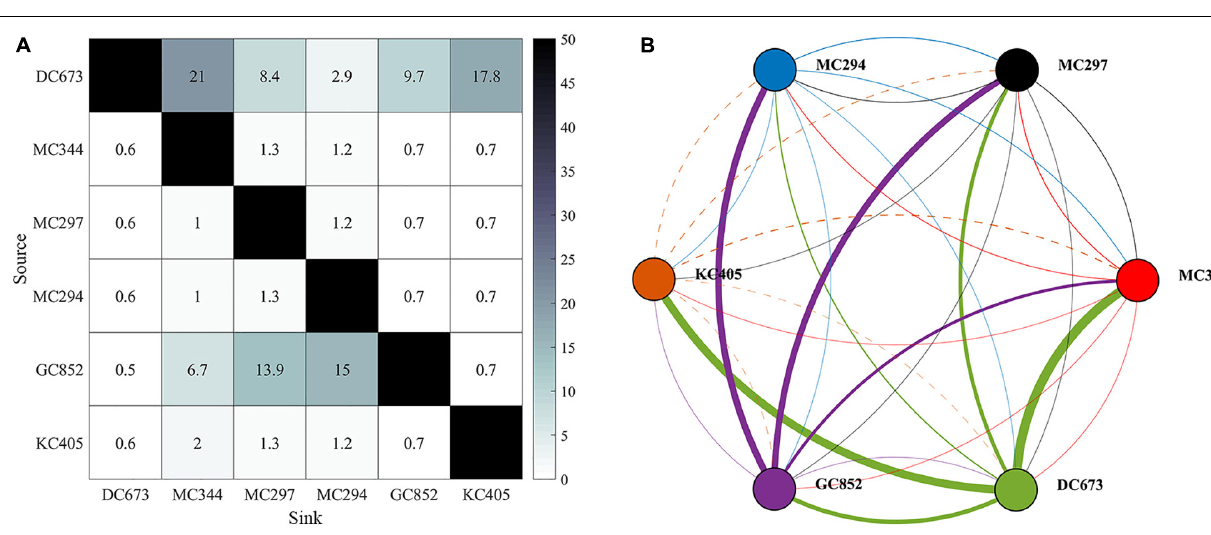
FIGURE 4 | Connectivity matrix (left) and network (right) calculated from genetic data sampled at the six locations shown in Figure 1A . Figures are modified from Galaska et al. (2021). (A) Matrix values correspond to point estimates of migration rates ( m ) as percentages (%). (B) Network lines represent connections (dash line for KC405) and dots sites. Dots are color-coded by site. The color of the lines indicates the source site for the connections. Linewidths are proportional to m values. Sites are arranged from east to west (from DC673 to